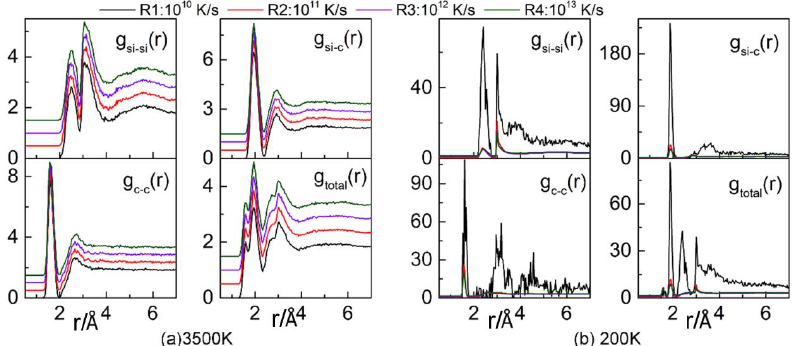
Figure 2. Evolution of the RDF of the liquid phase (the liquid region on the right) for different cooling rates at 3500 K ( a ) and 200 K ( b ). rates at 3500 K ( a ) and 200 K ( b After the system has been quenched and has reached a temperature of 200 K, g Total (r) and the partial RDFs of g C – C (r), g C – Si (r), and g Si – Si (r) show a clear crystallization trend for a cooling rate of 10 10 K/s. However, no crystallization is observed at higher cooling rates.